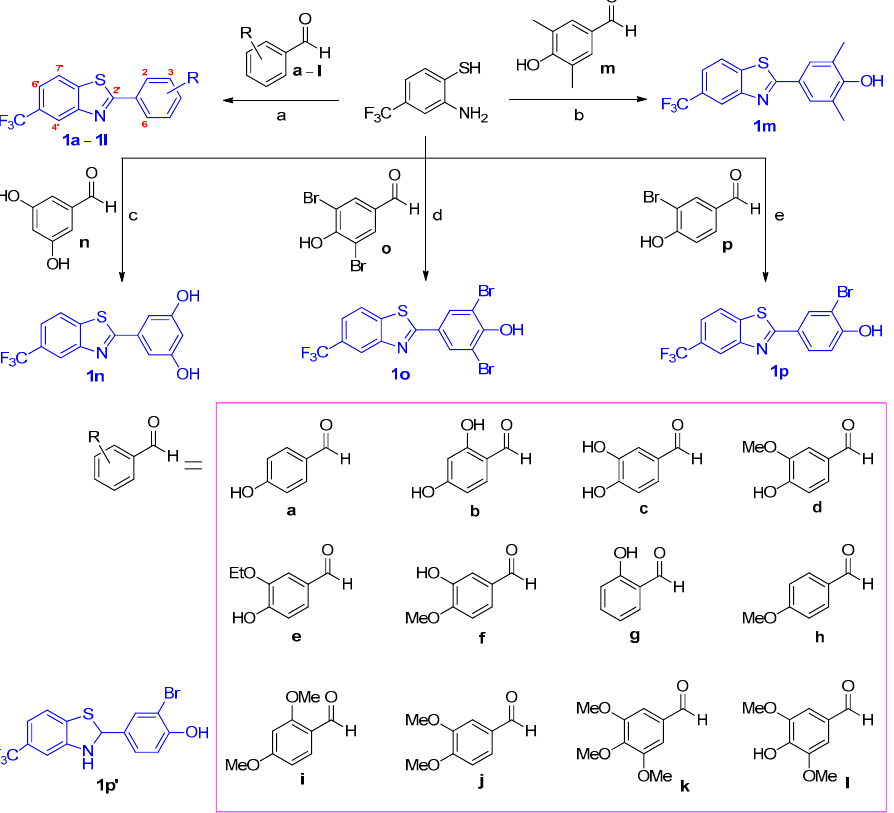
Scheme 1. Synthetic schemes for 2-(substituted phenyl)-5-(trifluoromethyl)benzo[ d ]thiazole deriv- atives 1a – 1p . Reagents and conditions: ( a ) MeOH, rt, 4–15 h, 28–68%; ( b ) Na 2 S 2 O 5 , DMF, 80 °C, 14 h, 51%; ( c ) NaOAc, AcOH, reflux, 7 h, 37%; ( d ) DMF, 100 °C, 13 h, 28%; ( e ) Na 2 S 2 O 3 , DMF, H 2 O, 80 °C, 16 h,